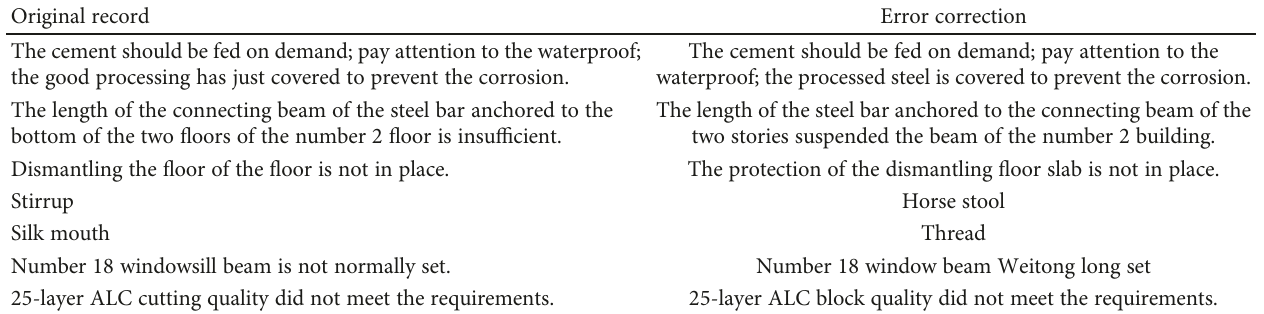
Table 2: Record error correction record.